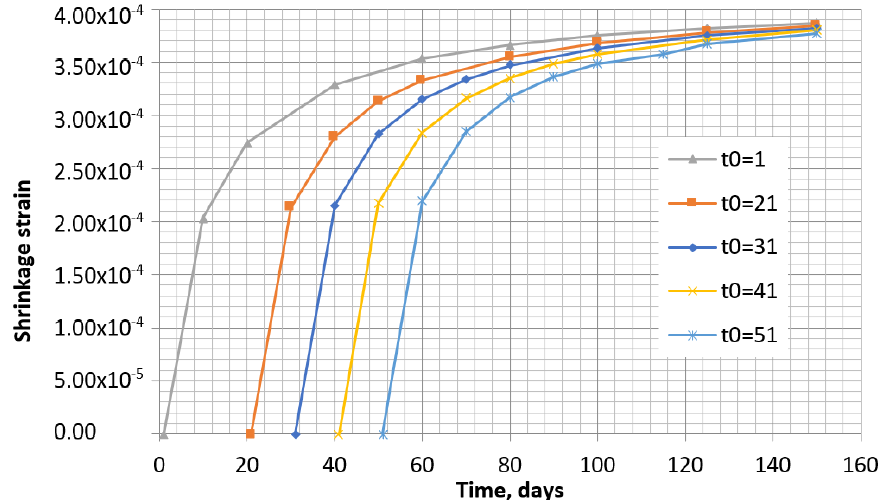
Figure 9. Shrinkage of concrete specimens according to EC2 model at the different drying start times when humidity is 70%.